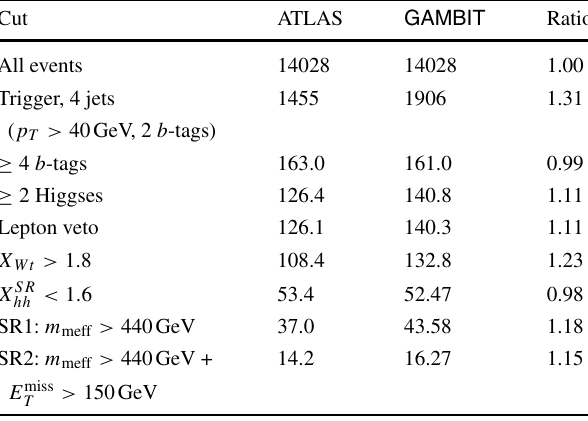
Table 4 Example comparison of GAMBIT and ATLAS [120] cutflows for two signal regions targeting low-mass Higgsinos in a search for new physics in events with two Higgs bosons decaying into ¯ bb . Shown are the numbers of events expected in 24.3 fb − 1 of 13 TeV ATLAS data for Higgsino pair production with a signal cross-section of 0.577 pb, = 250 GeV and a massless gravitino, assuming 100% branching m ˜ H fraction for ˜ H → h ˜